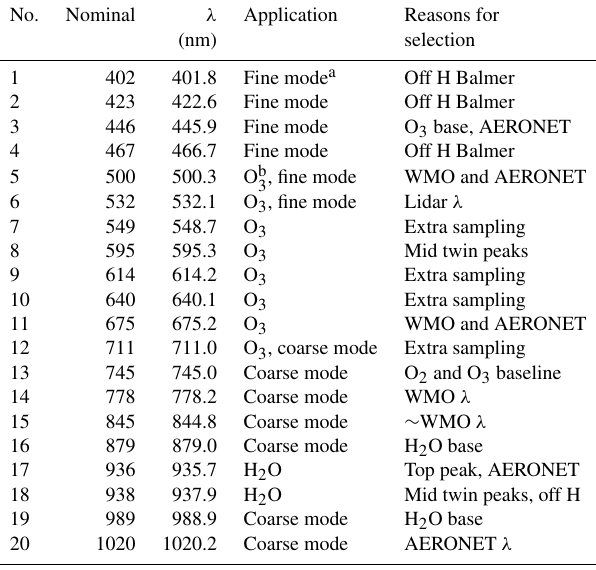
Table 2. Specifications for the 20 starphotometry channels chosen according to the absorption feature avoidance process outlined in the text (see the text for details on the reason(s) for